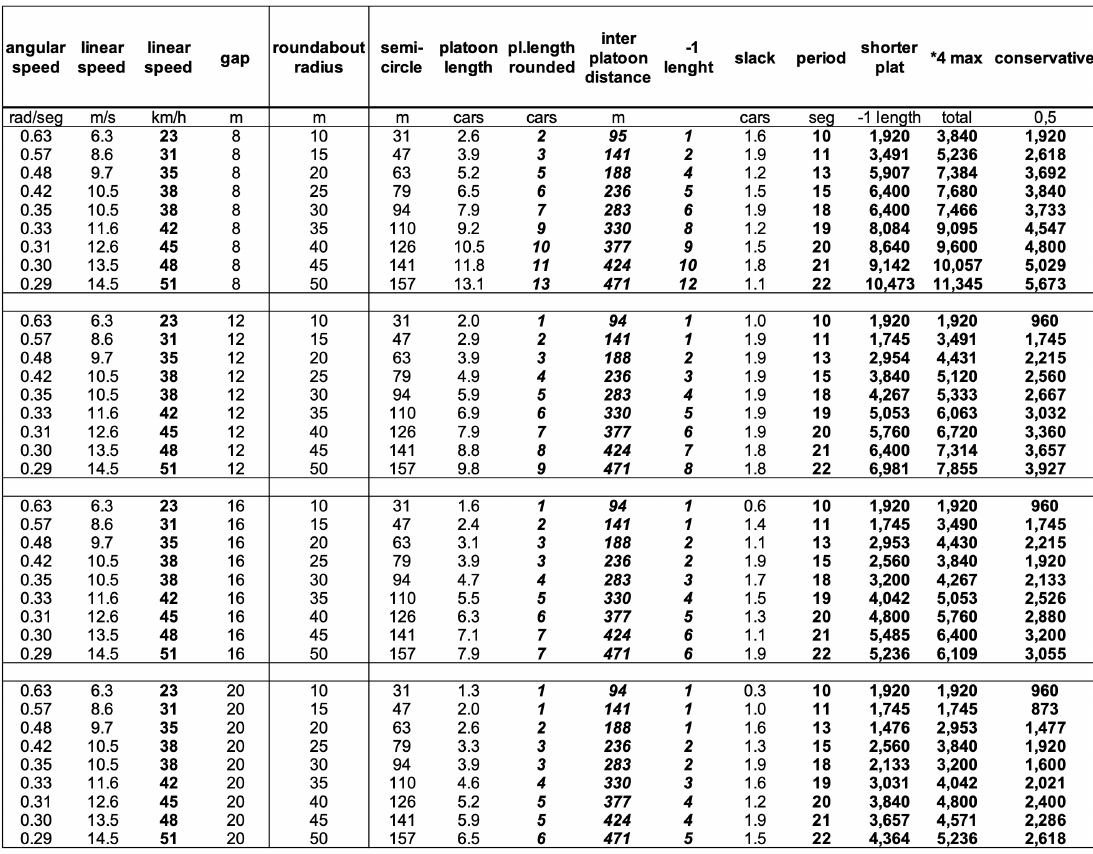
Figure 12. Roundabout